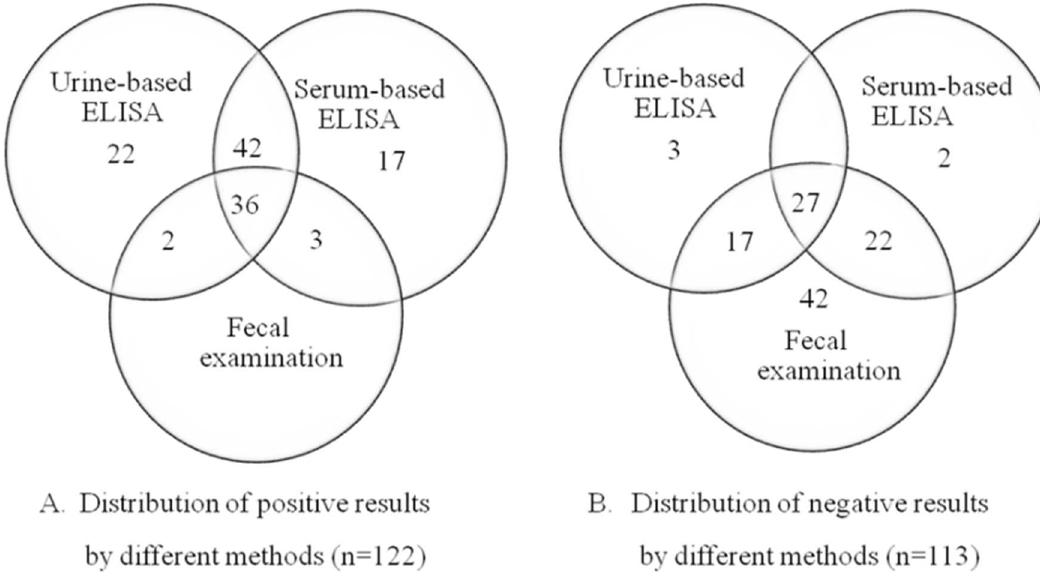
Fig 2. Venn diagrams comparing the distribution of positive and negative results by each diagnostic